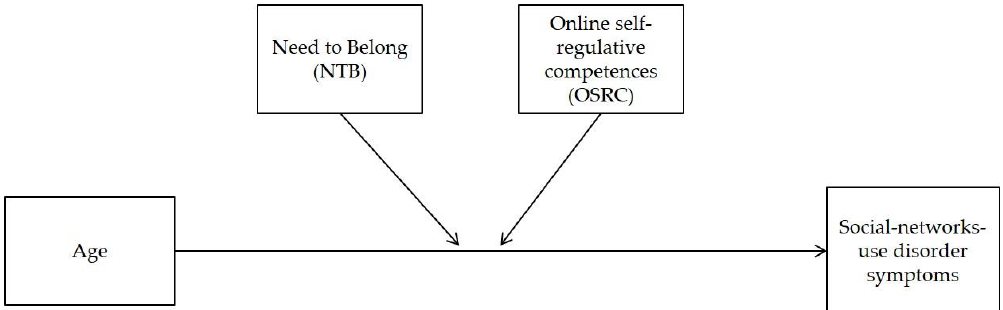
Figure 1. Hypothesized moderated regression model with age, need to belong (NTB), and online self-regulative competences (OSRC) as (moderating) predictors for a social-networks-use disorder.